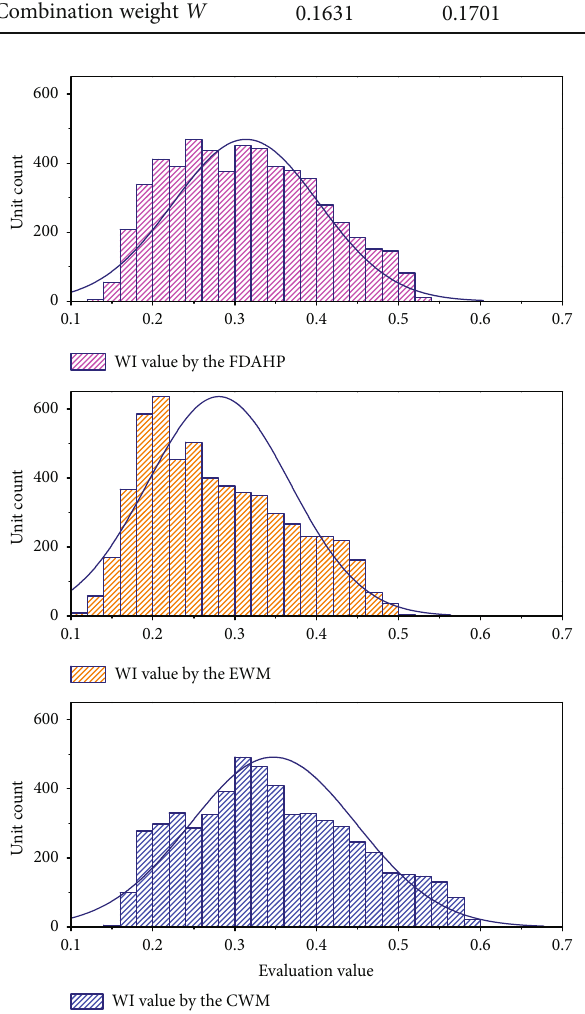
Figure 6: Frequency histogram of the